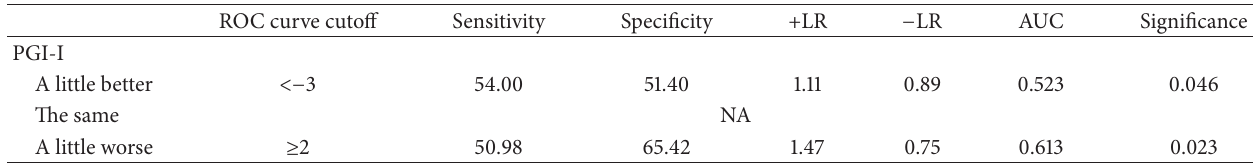
Table3:BestcutoffvaluesdiscriminatingminimalclinicallyimportantdifferencesforPDSS-2determinedbyreceiveroperatingcharacteristic